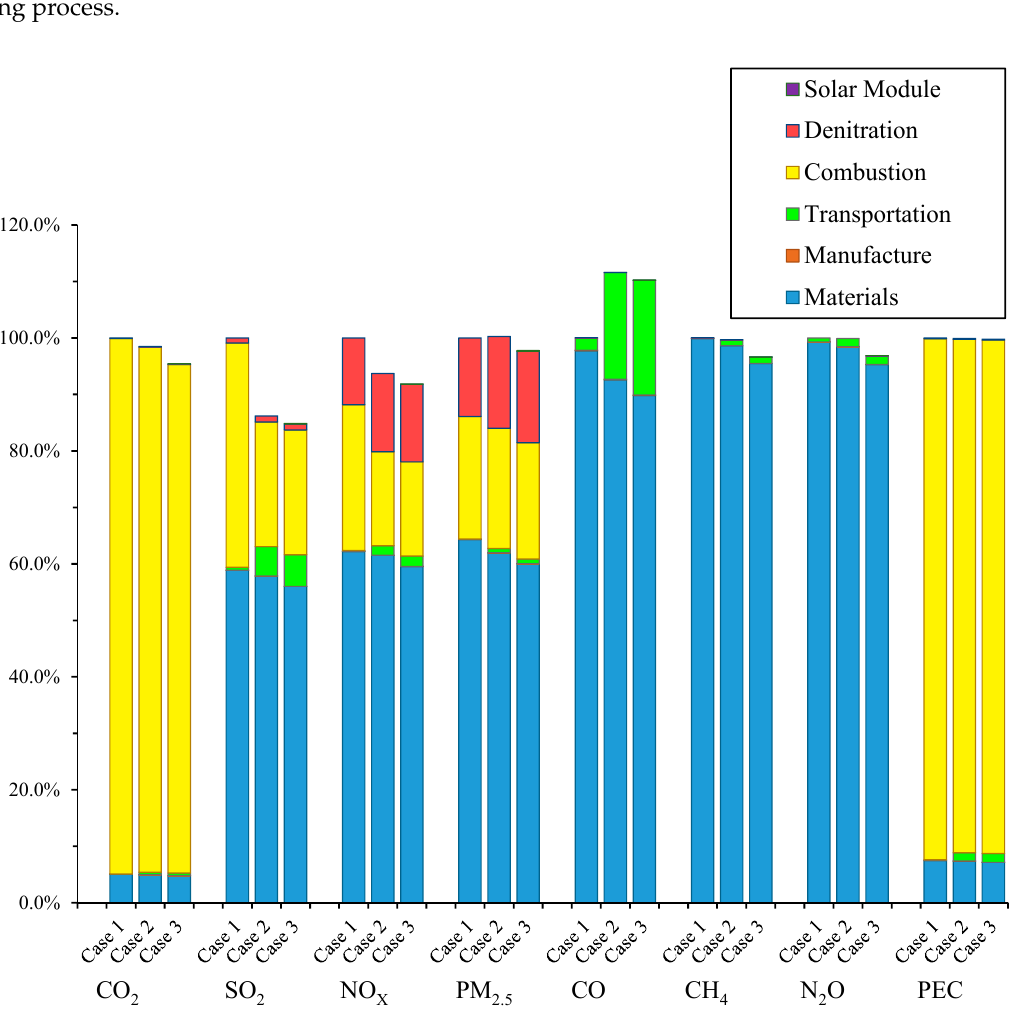
Figure 7. Normalized life cycle pollutant emissions and PEC results.